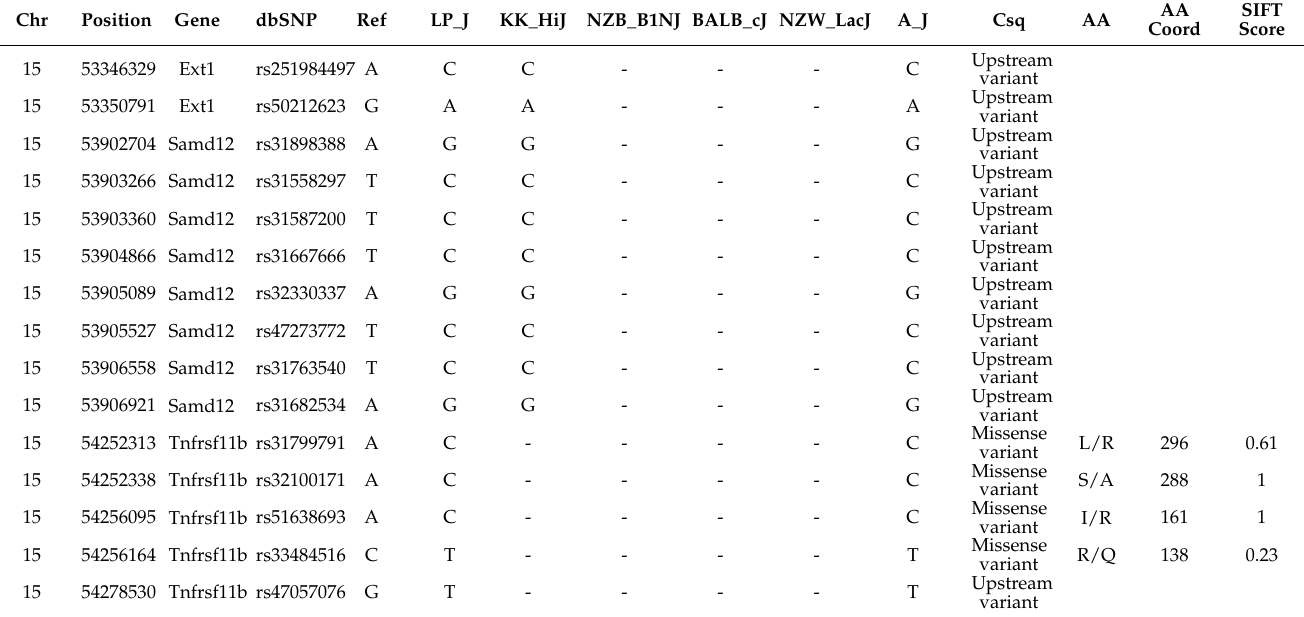
Table 2. Positional candidate genes for Bglu19 on chromosome 15 identified by haplotype analysis.